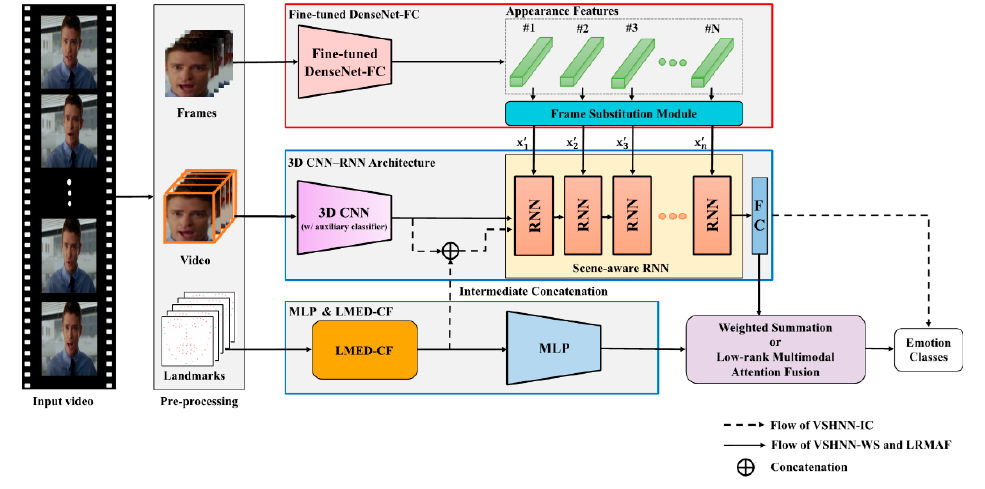
Figure 7. Block diagram of VSHNN-LRMAF.